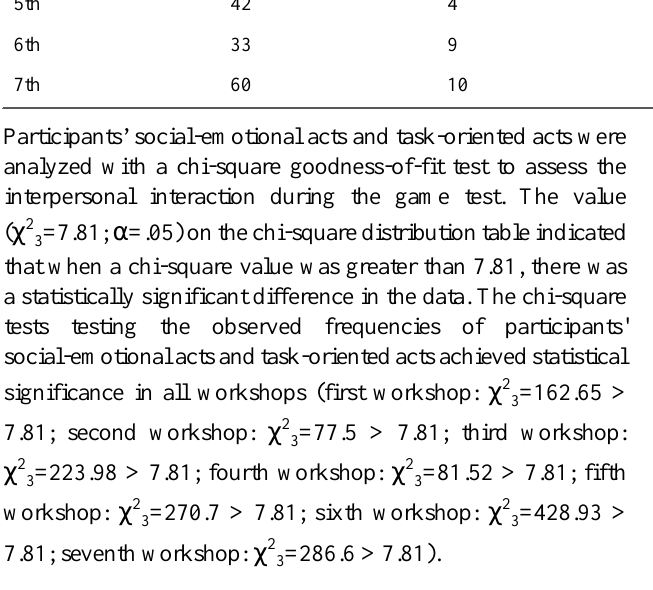
Game scoreTask-oriented actsSocial-emotional actsGame test workshop